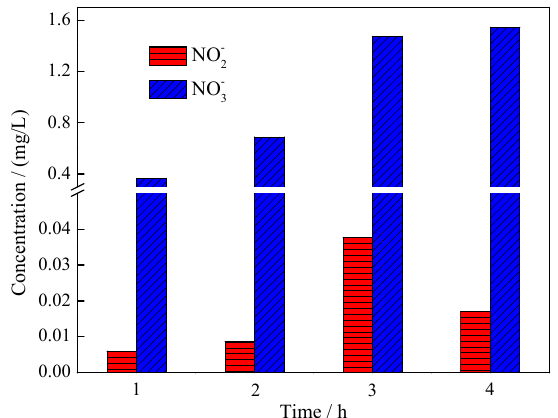
Figure 9. Changes in NO 3 − and NO 2 − concentrations in the photocatalytic degradation of benzohydroxamic acid by 0.50% Yb/TiO 2 .